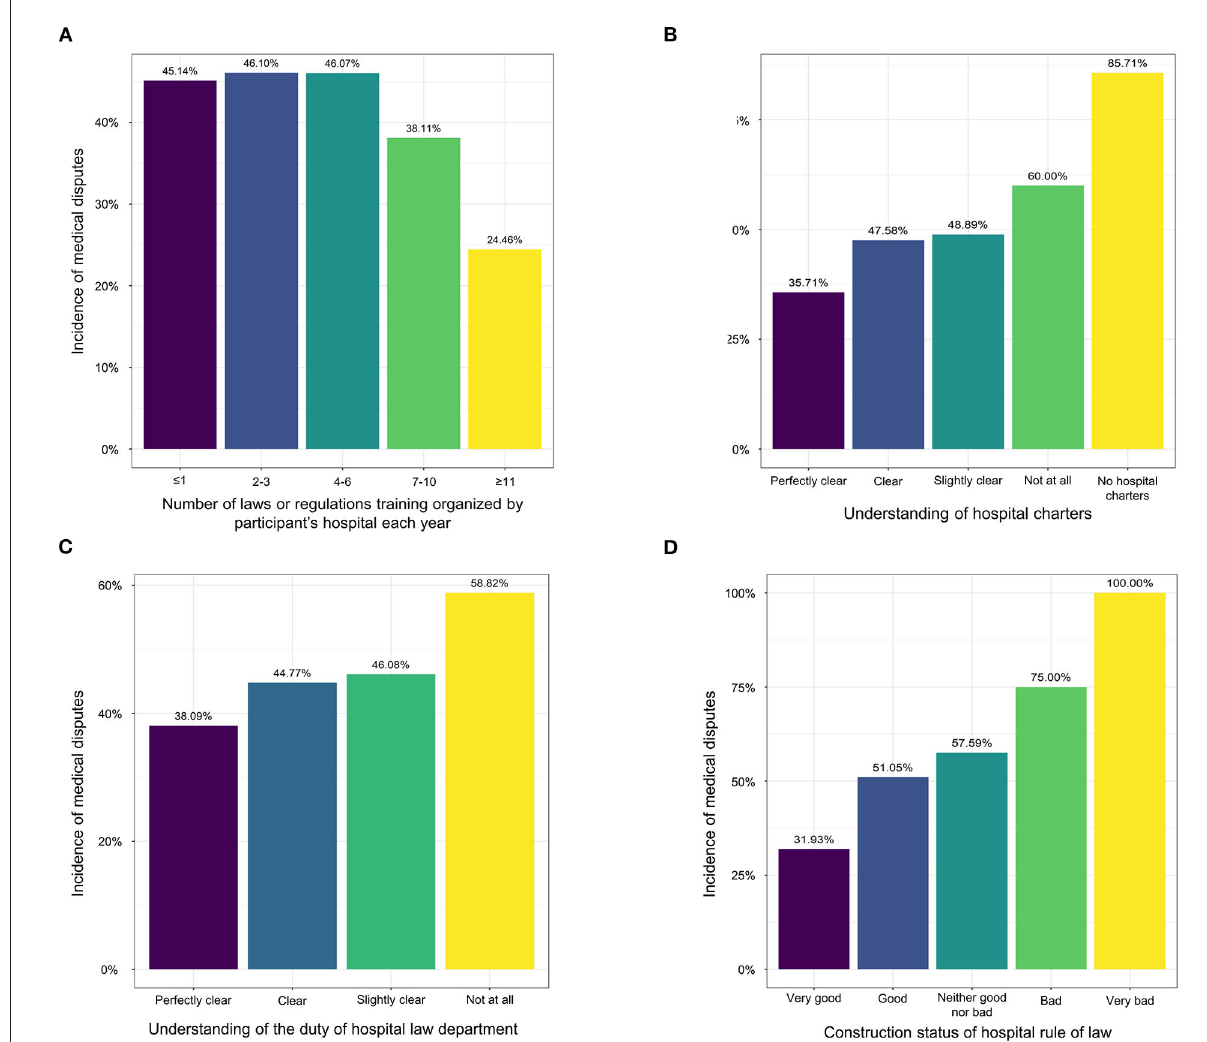
FIGURE2 Histograms of the incidence of medical disputes in relation to hospital legal constructions and administrator’s knowledge on hospital rule of law. (A) Number of laws or regulations training organized by participant’s hospitals each year; (B) understanding of hospital charters; (C) understanding of duty of hospital law department; (D) construction status of hospital rule of